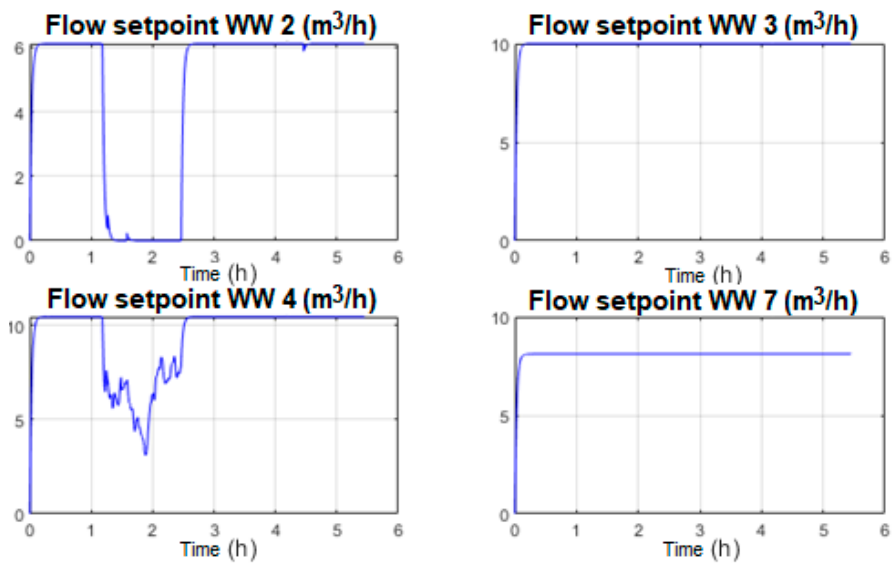
Figure 14. Water well flow references.